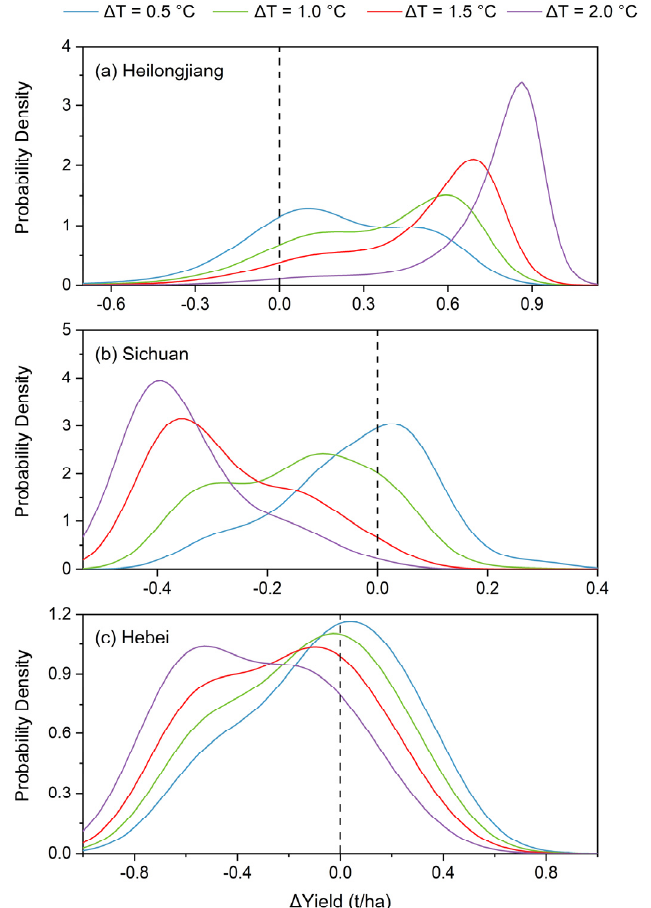
Figure 5. Conditional probability distribution of yield variation ( ∆ Yield) given four warming con- ditions ( ∆ T GS = 0.5, 1, 1.5, and 2 °C) for ( a ) Heilongjiang province (rice), ( b ) Sichuan province (wheat), and ( c ) Hebei province (maize),